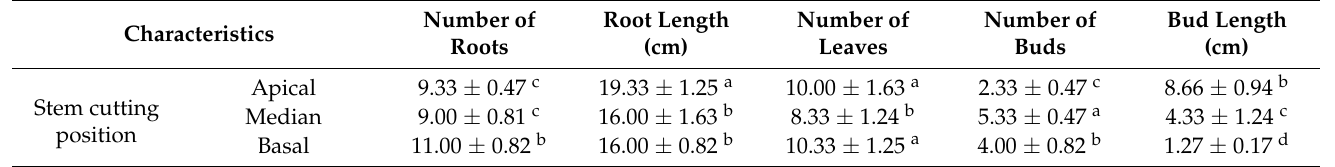
Figure 5. Rooting and sprouting of leafy and non-leafy stem cutting of C. indicum in the substrate containing vermiculite and perlite (1:1). ( A – C ) Cuttings treated with 2000 ppm of IBA. ( A ) Apical cutting, ( B ) median cutting, ( C ) basal cutting. ( D – F ) Cuttings in the absence of auxin treatment (control). ( D ) Apical cutting, ( B ) median cutting, ( C ) basal cutting. L: leafy, NL; non-leafy cutting. Table 1. The effect of stem cutting position and growth substrates on root number, root length, leaf number, bud length, and bud number in C. indicum